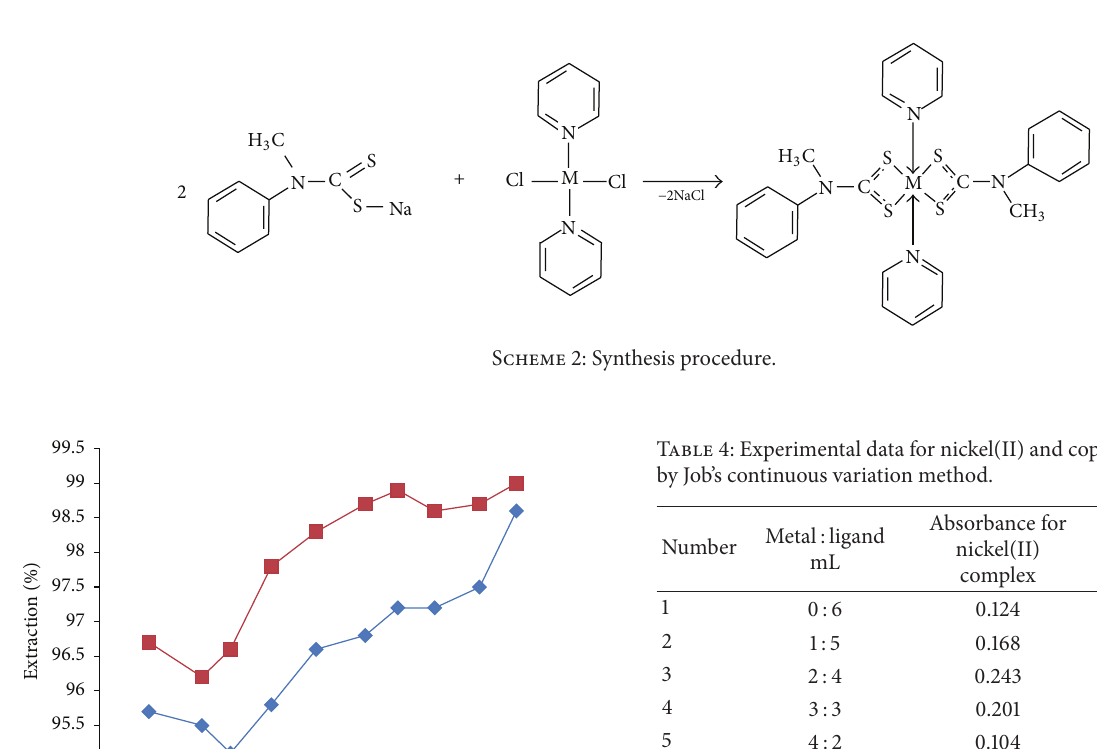
Scheme 1: Schematic representation of the extraction process.